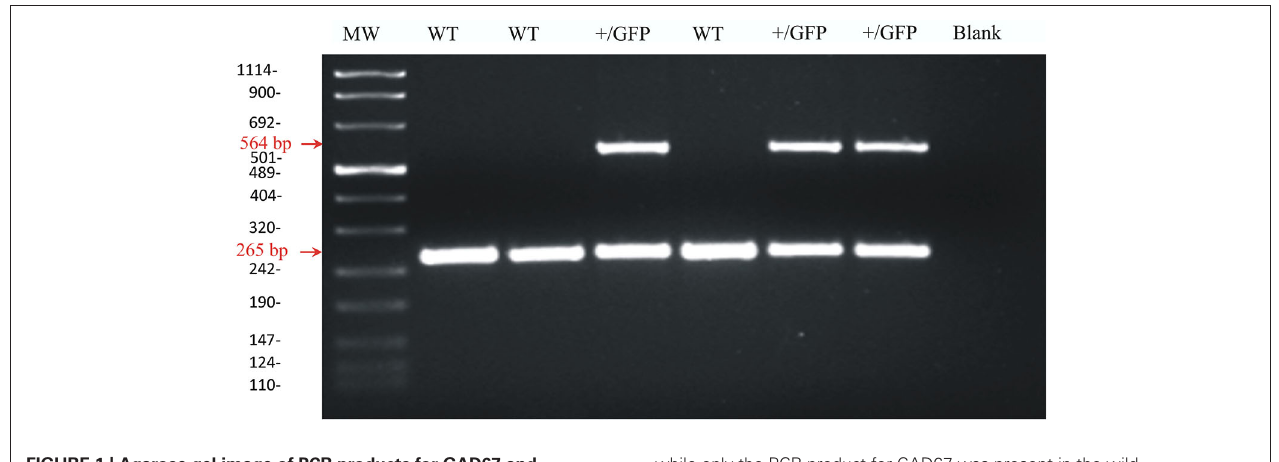
FIGURE 1 | Agarose gel image of PCR products for GAD67 and GAD67-GFP from wild-type and heterozygous GAD67-GFP knock-in mice . Representative PCR products for GAD67 (265 pb) and GAD67-GFP (564 pb) were observed in +/GFP lanes ( n = 3)